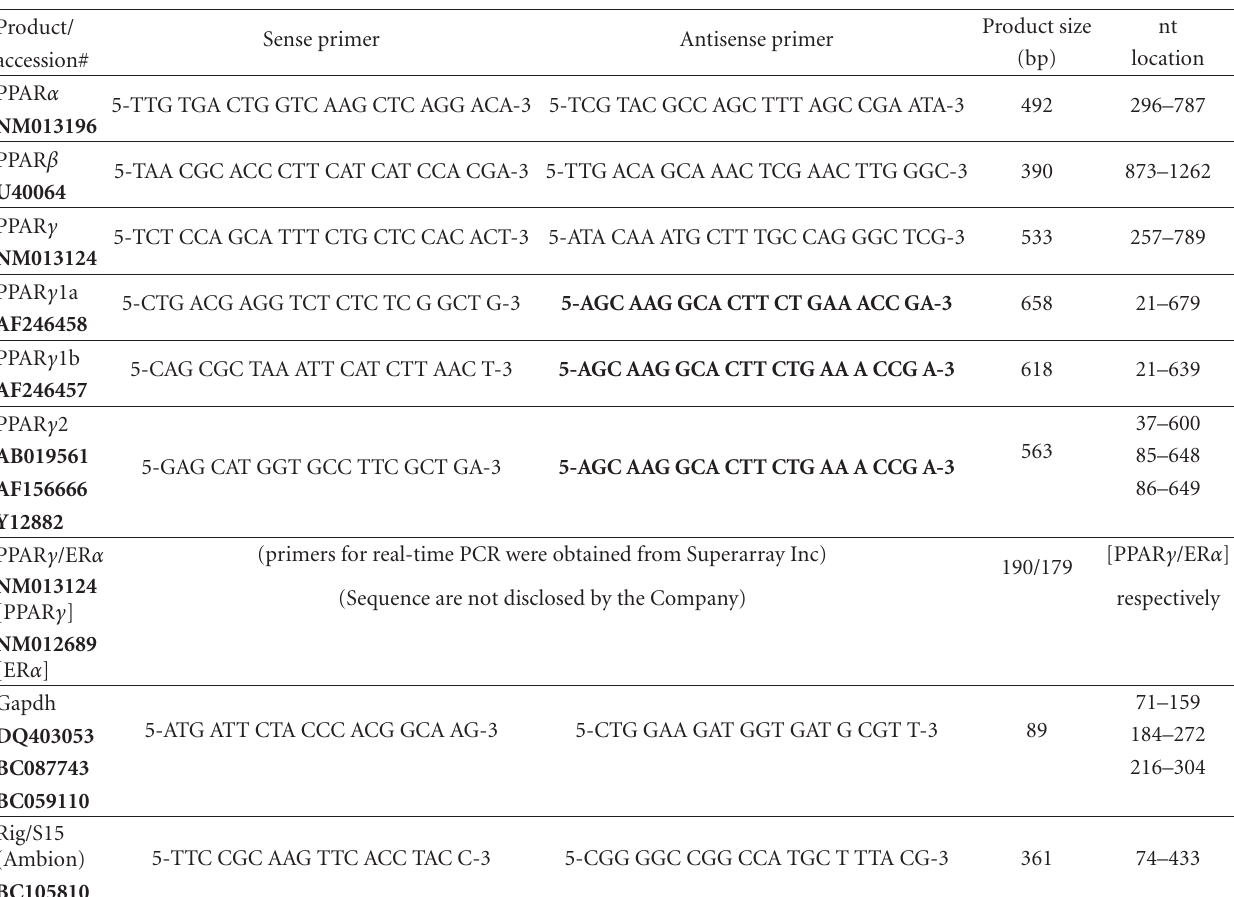
Table 1: PCR primer sets, sequence, product size (bp), nucleotide (nt) location, and GenBank accession numbers for rat PPARs used in this study. Note that a common antisense oligoprimer (sequence in bold) was used for PPAR γ 1a, PPAR γ 1b, and PPAR γ